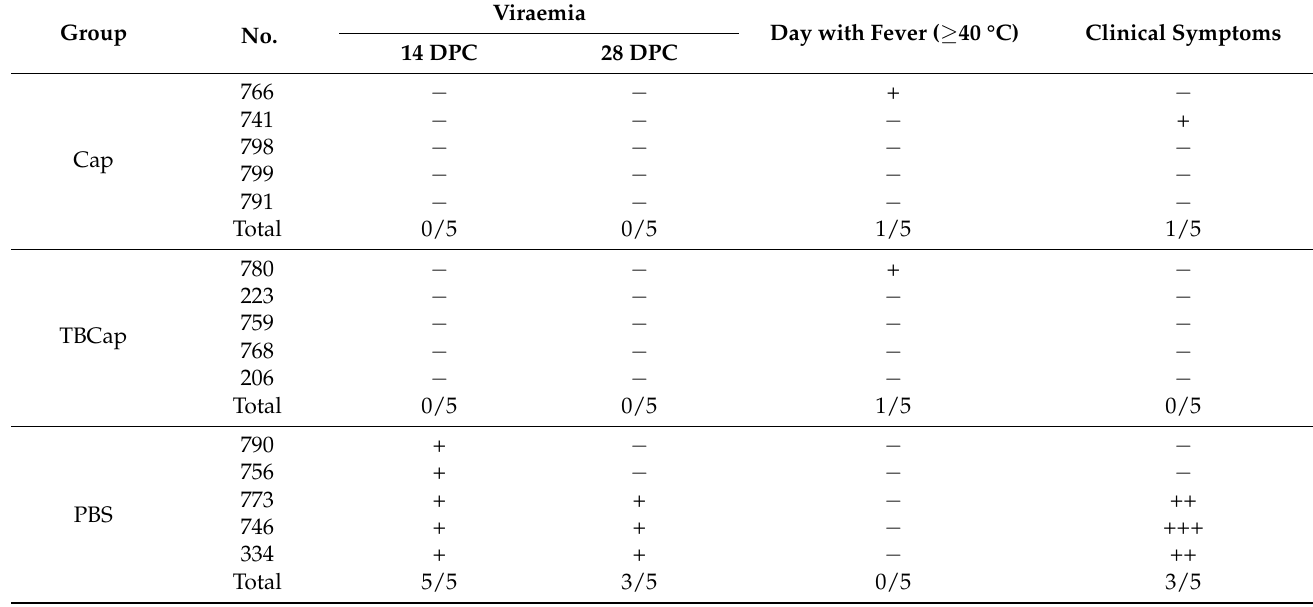
Table 1. Viraemia and clinical signs in piglets after challenge.